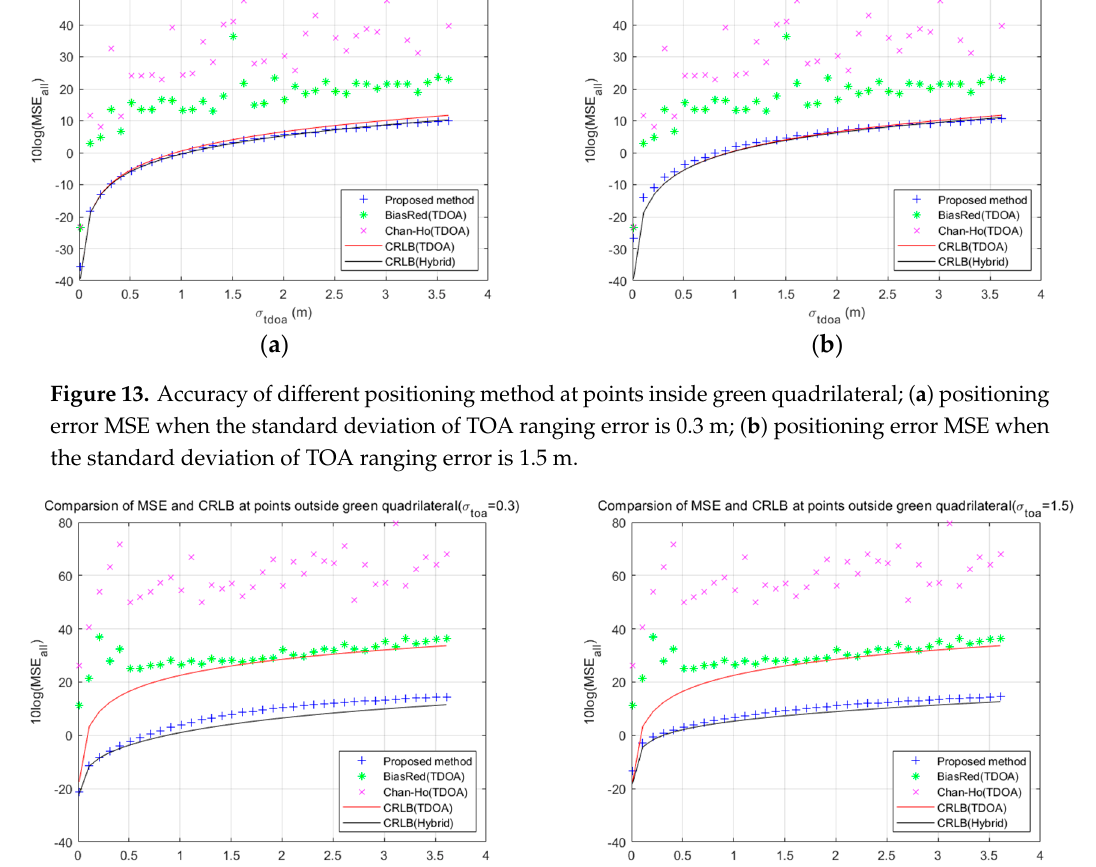
Figure 13. Accuracy of different positioning method at points inside green quadrilateral; ( a ) positioning error MSE when the standard deviation of TOA ranging error is 0.3 m; ( b ) positioning error MSE when the standard deviation of TOA ranging error is 1.5 m.